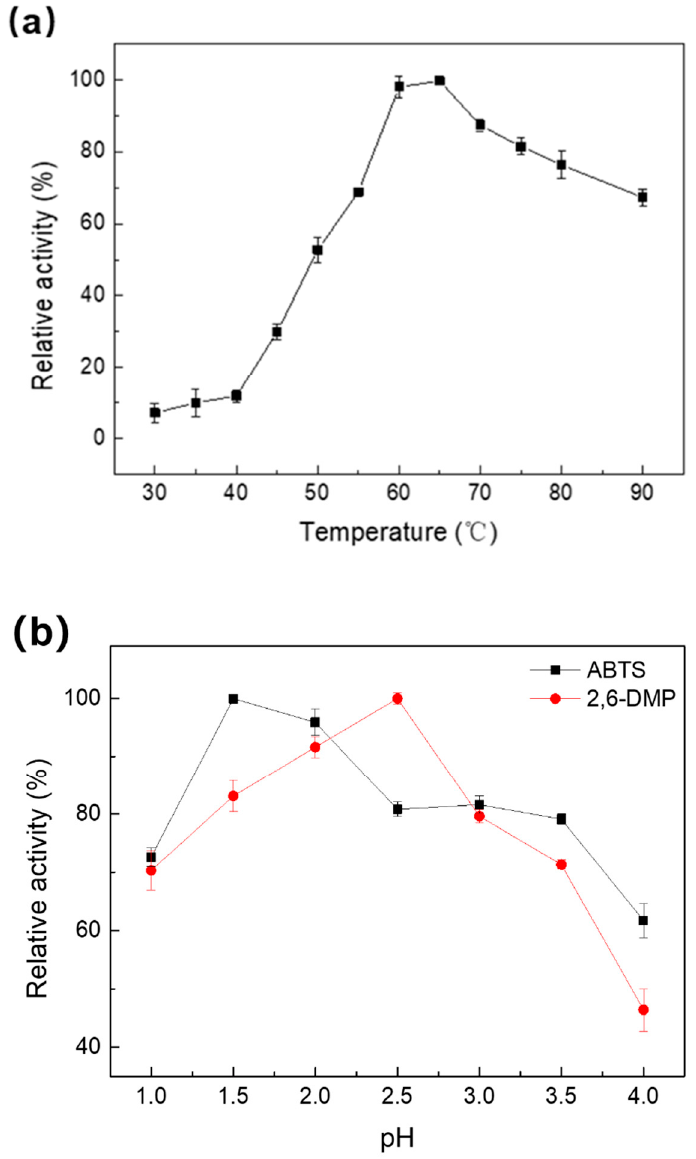
Figure 2. Characterization of purified recombinant Melac13220 from Methylobacterium extorquens ; ( a ) optimal temperature in reaction with ABTS as a substrate; ( b ) optimal pH in reaction with ABTS and 2,6-DMP. All experiments were performed in triplicate, and the results represent mean ± standard deviation.